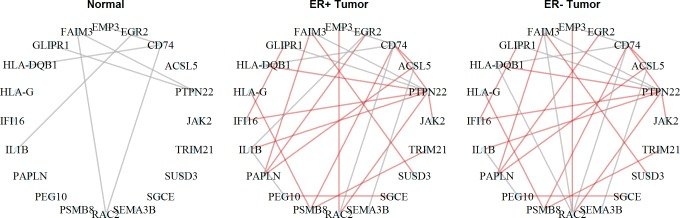
An example of ER+/ER- shared module in TCGA breast cancer data.The genes in the module are enriched in GO term of Antigen binding. The hub gene of the module, PTPN22, was found associated with an immune function in breast cancer. Red: common edges shared by two tumor tissues. Grey: all other edges.